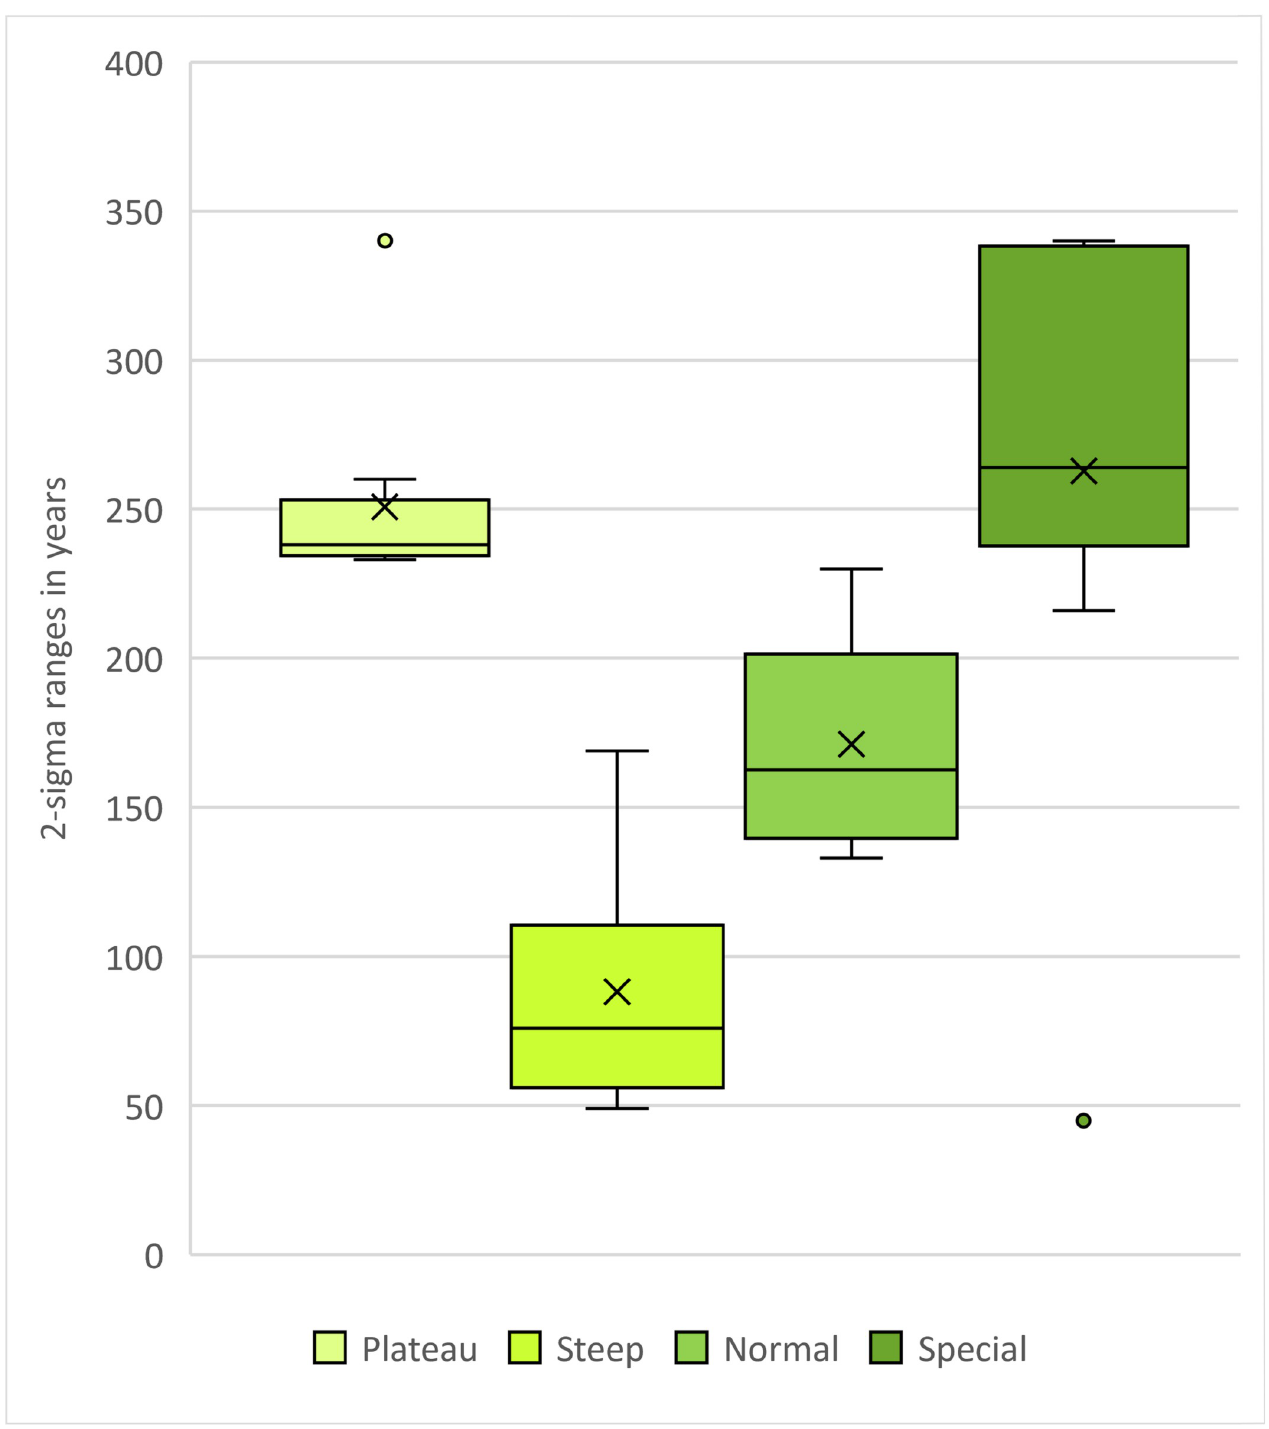
Fig 6. Whisker-Box-plots showing 2-sigma ranges of the calibrated dates used for the four pedigree simulations. Parameters and results in Fig 5.